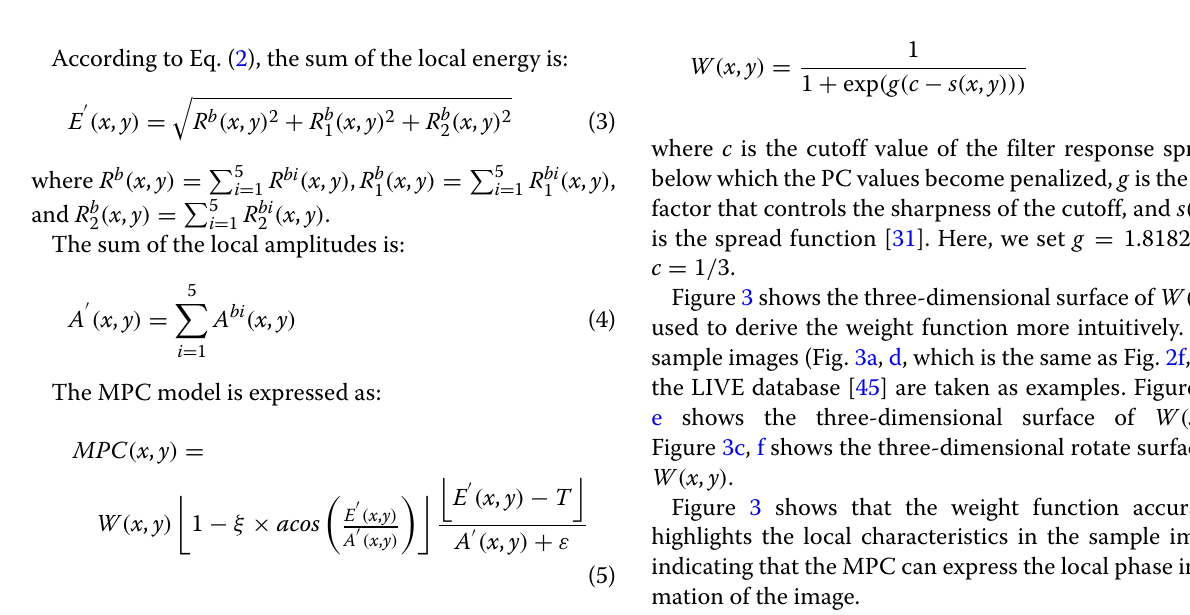
l m n o p q Fig. 2 Twoexamples and their Log-Gabor filter banks. a – e Forms of filter bank. Their center frequencies are ω 01 = 1 = 1 ω , and ω 05 = 1 respectively. f – k The original image monarch and the different components of the corresponding five 04 3 2.1 × 2.1 × 2.1 3 2.1 × 2.1 × 2.1 × 2.1 bands. l – q The original image sailing 2 and the different components of the corresponding five